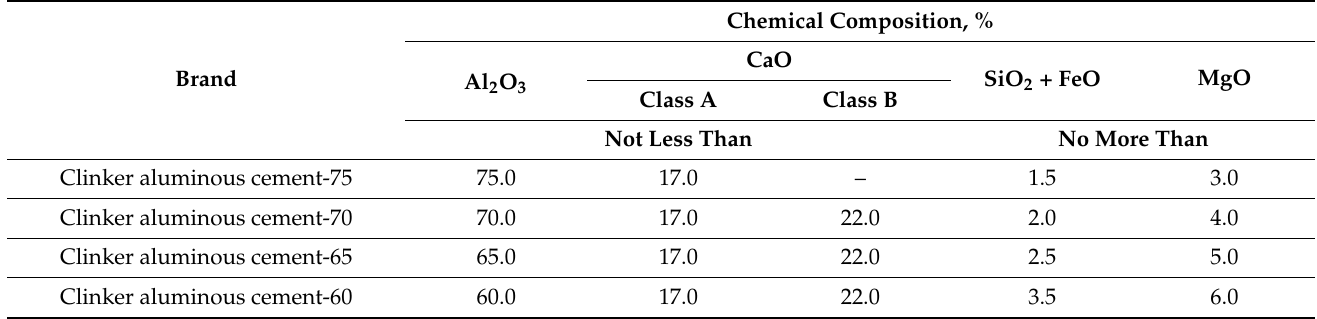
Table 10. High-alumina clinkers of aluminothermic production according to TU 14-11-138-86 stan-